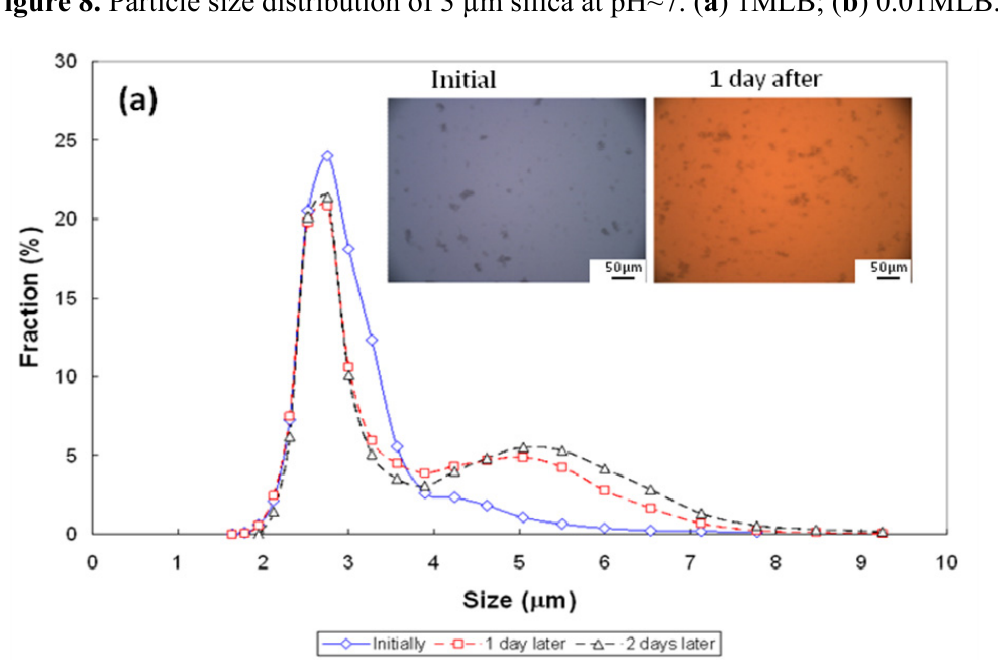
Figure 8. Particle size distribution of 3 µm silica at pH~7. ( a ) 1MLB; ( b )